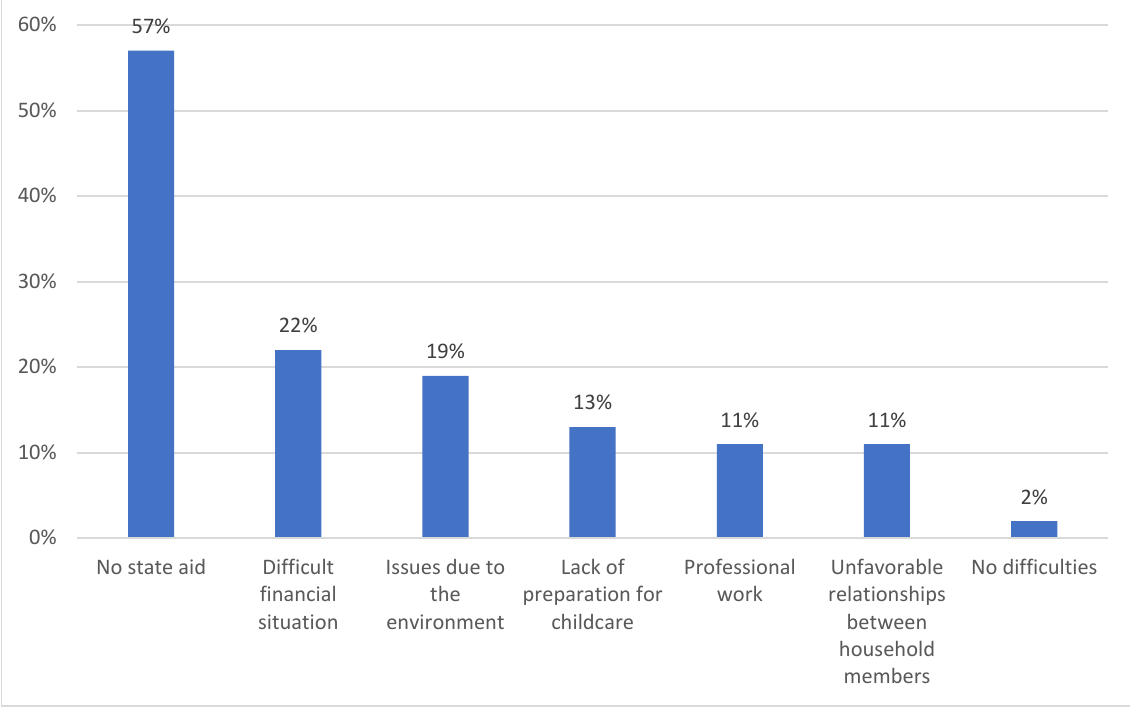
Figure 1. The sources of the caring problems.